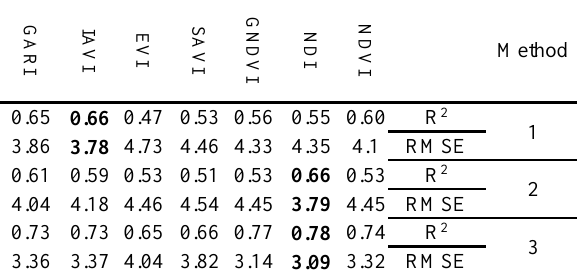
Table 3. comparison of model evaluation coefficients